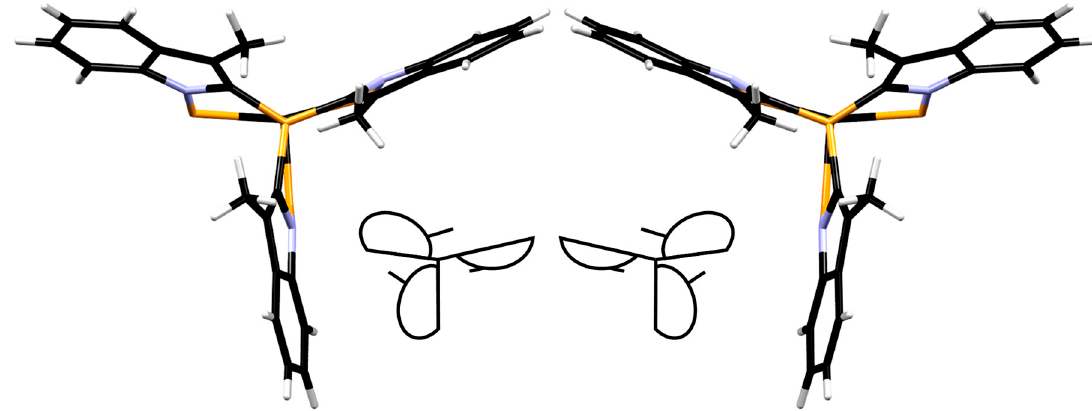
Figure 5. Drawing of bottom view of RuCl 2 L1 CF3 of both isomers, showing only the (3-methylindolyl)phosphine part. Insert: schematic representation of the two rotamers with the 3-methylindolyl moiety twisted clockwise ( left ) or counter-clockwise ( right ).